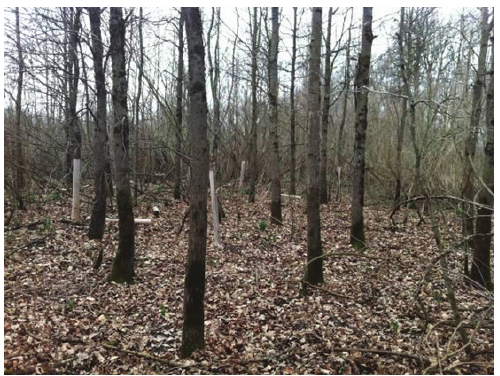
FIGURE 4. An experimental plot of the pedun- culate oak forest stand regenerated 18 years ago by polypropylene tree shelters in the Kutina Lowland Forest management unit (Forest Office Kutina,30 March